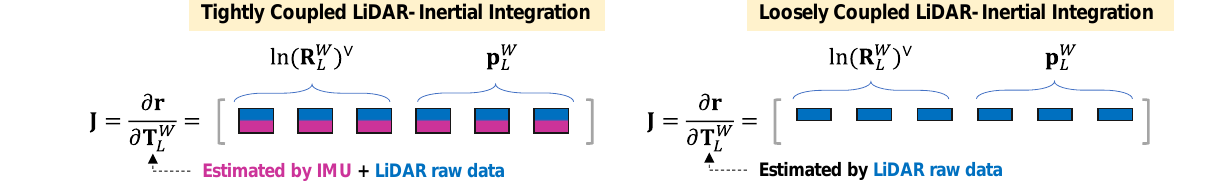
Figure 7. Impact of the error from IMU measurement and LiDAR measurement on LiDAR scan-to-map registration. When computing the residual and the Jacobian matrix during the registration, in TC-LIO, errors from both IMU and LiDAR are involved in the shared states. While in LC-LIO, only error from LiDAR measurement can exert some impacts.